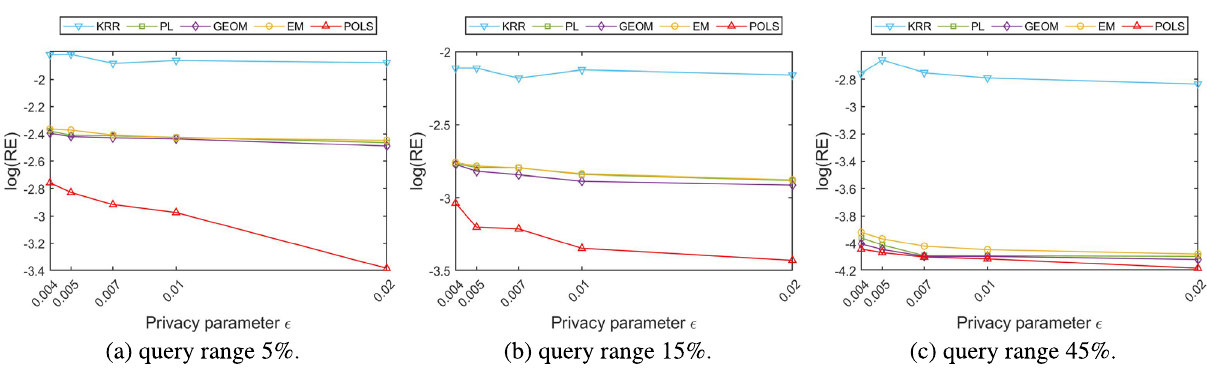
Figure 12. Comparison of range counting query accuracy (dataset with 100,000 users).